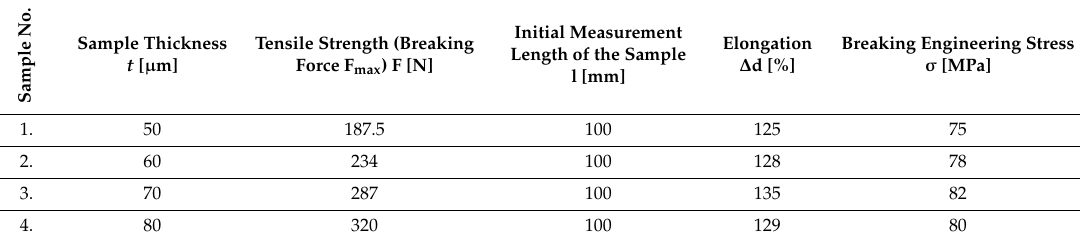
Table 1. Longitudinal tensile strength test results.